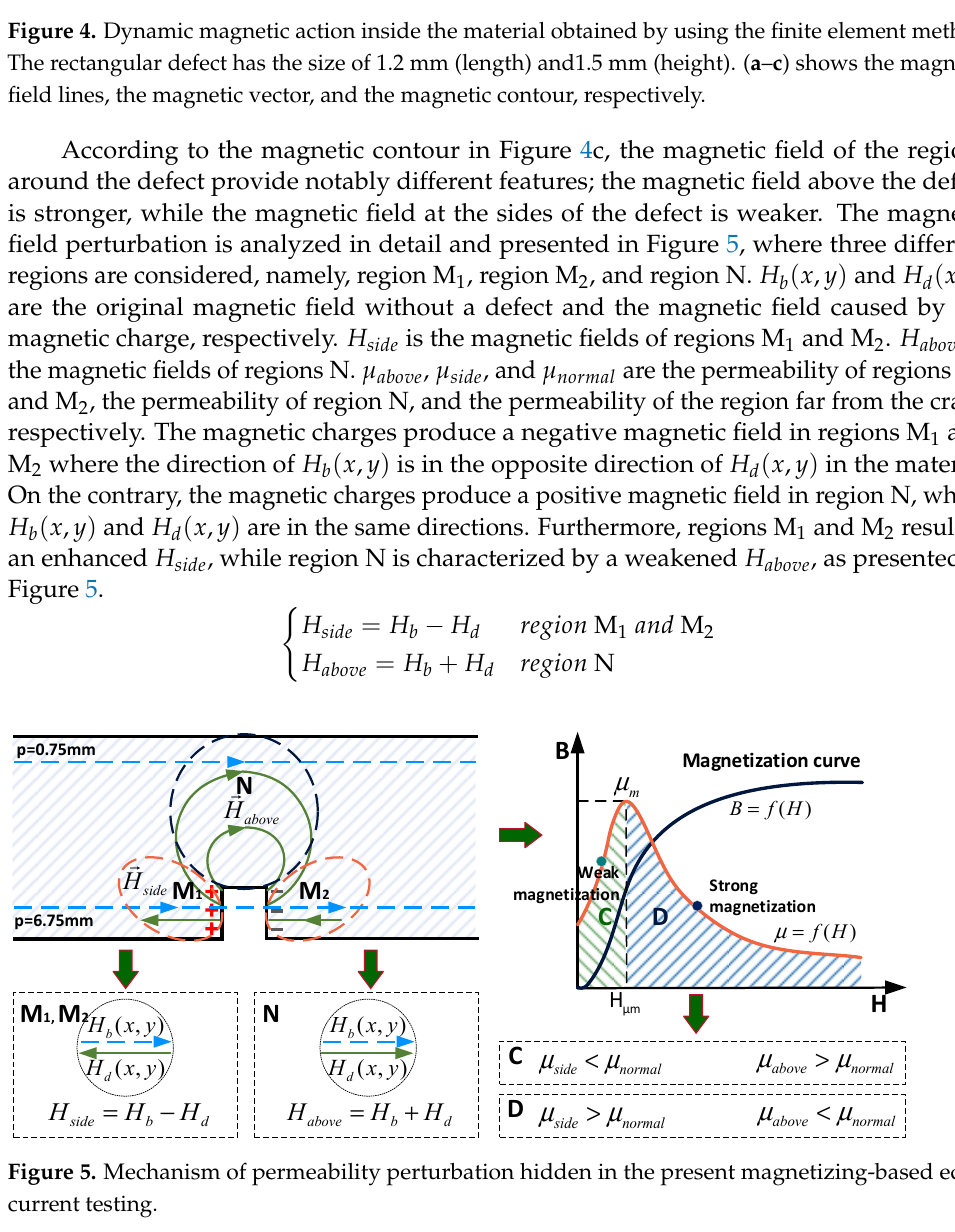
regions are considered, namely, region M 1 , region M 2 , and region N. H b ( x , y ) and H d ( x , y )